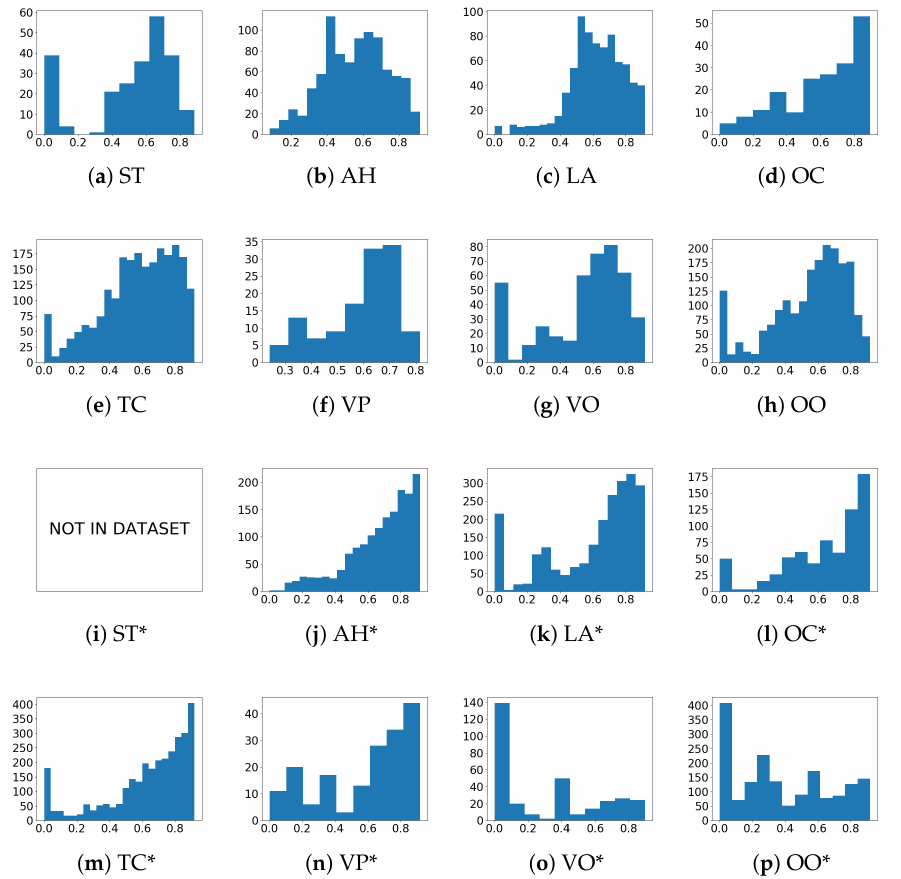
Figure 4. Decision histograms per anomaly class ( ST : collision with a starting, stopping, or stationary vehicle; AH : ahead collision; LA : lateral collision; OC : oncoming collision; TC : turning or crossing collision; VP : vehicle-pedestrian collision; VO : vehicle-obstacle collision; * indicates non-ego; OO : out-of-control leaving roadway). The x -axis represents decision d t ∈ [ 0,1 ] , and the y -axis represents the frame count per bin.